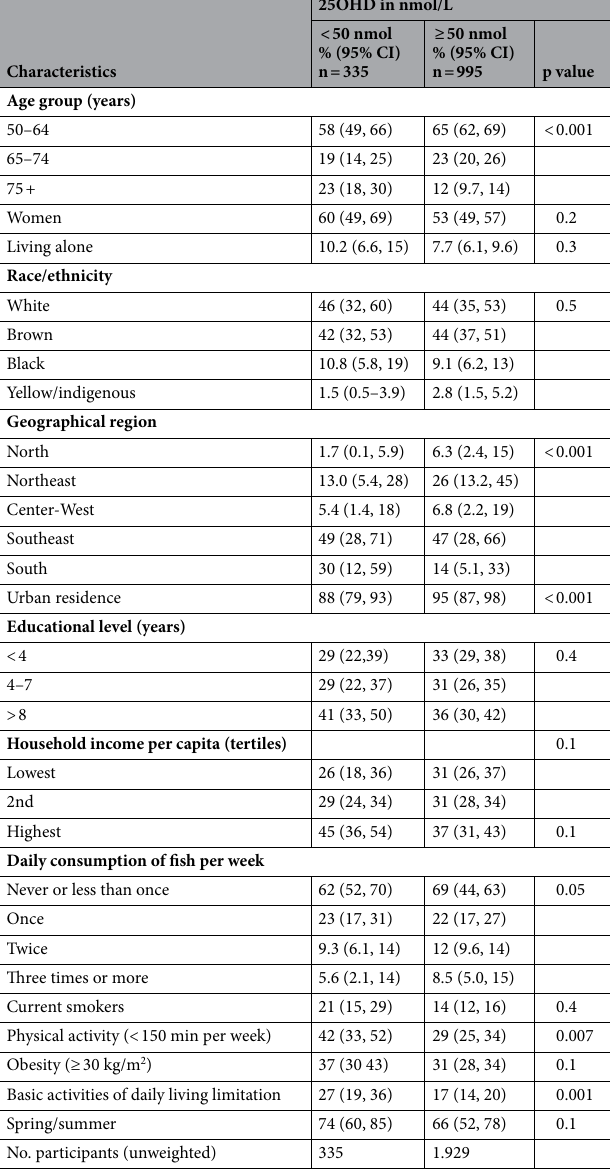
Table 2. Sociodemographic characteristics, lifestyle and season of blood collection by 25OHD serum level by serum 25-hydroxyvitamin D (25OHD) concentrations in participants of the Brazilian Longitudinal Study of Aging (ELSI), 2015–16. The percentages were estimated considering the sample parameters and the weights of the individuals in the sample. P value: Pearson’s chi square test with Rao–Scott correction for differences across